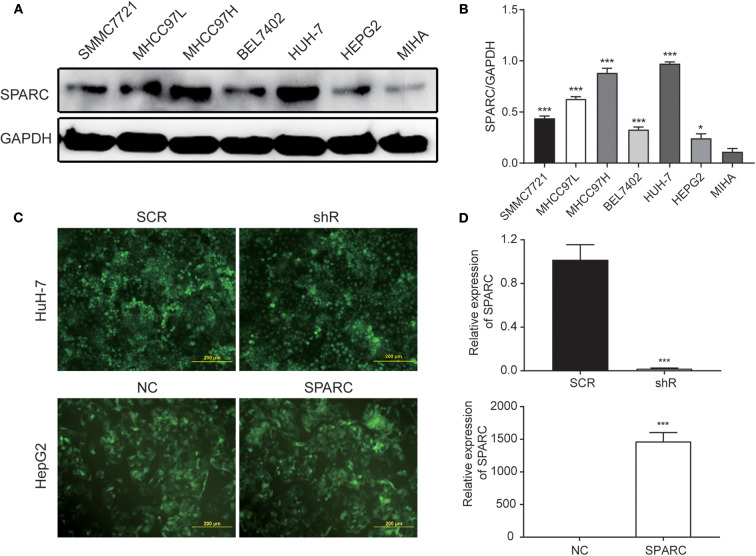
Cell infection. (A,B) Western blotting was performed to compare the expression of SPARC in HCC cell lines, namely SMMC7721, MHCC97L, MHCC97H, BEL7402, HUH-7, and HEPG2, as well as in the MIHA normal liver cell line. (C,D) Infection efficiency of lentivirus was expressed by green fluorescent. The efficiency of the 72 h infection with the shR and SPARC lentiviruses was found to be over 80%. Likewise, the efficiency of the knockdown and overexpression of SPARC following the 72 h infection with shR and SPARC lentiviruses were evaluated via RT-qPCR analysis, and found to be over 80%. *p < 0.05 and ***p < 0.001. SCR, scramble-sequence; NC, negative control; shR, SPARC-shRNA; SPARC, SPARC-infected.